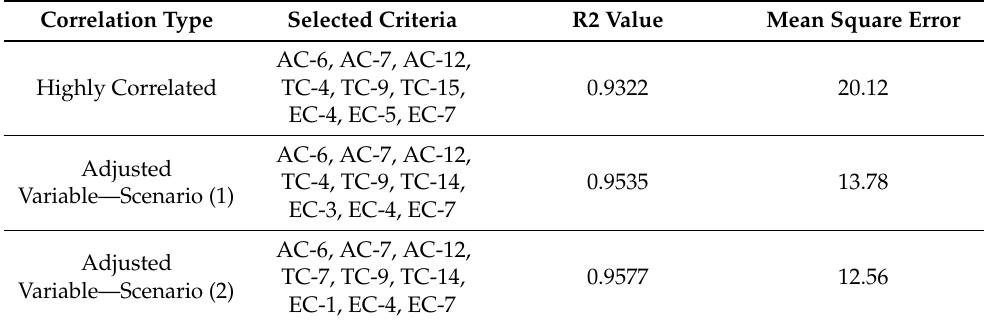
Table 7. Results and